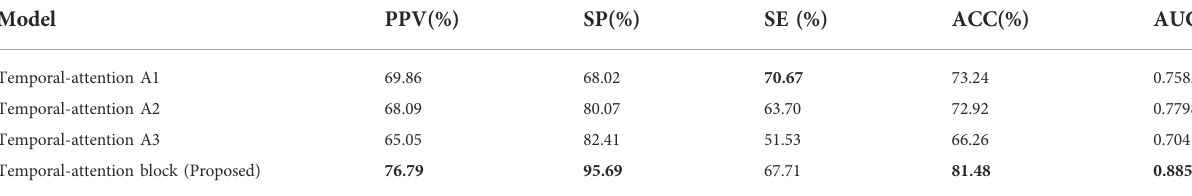
TABLE 7 Performance of adding attention block model on fi ve-fold cross-validation.